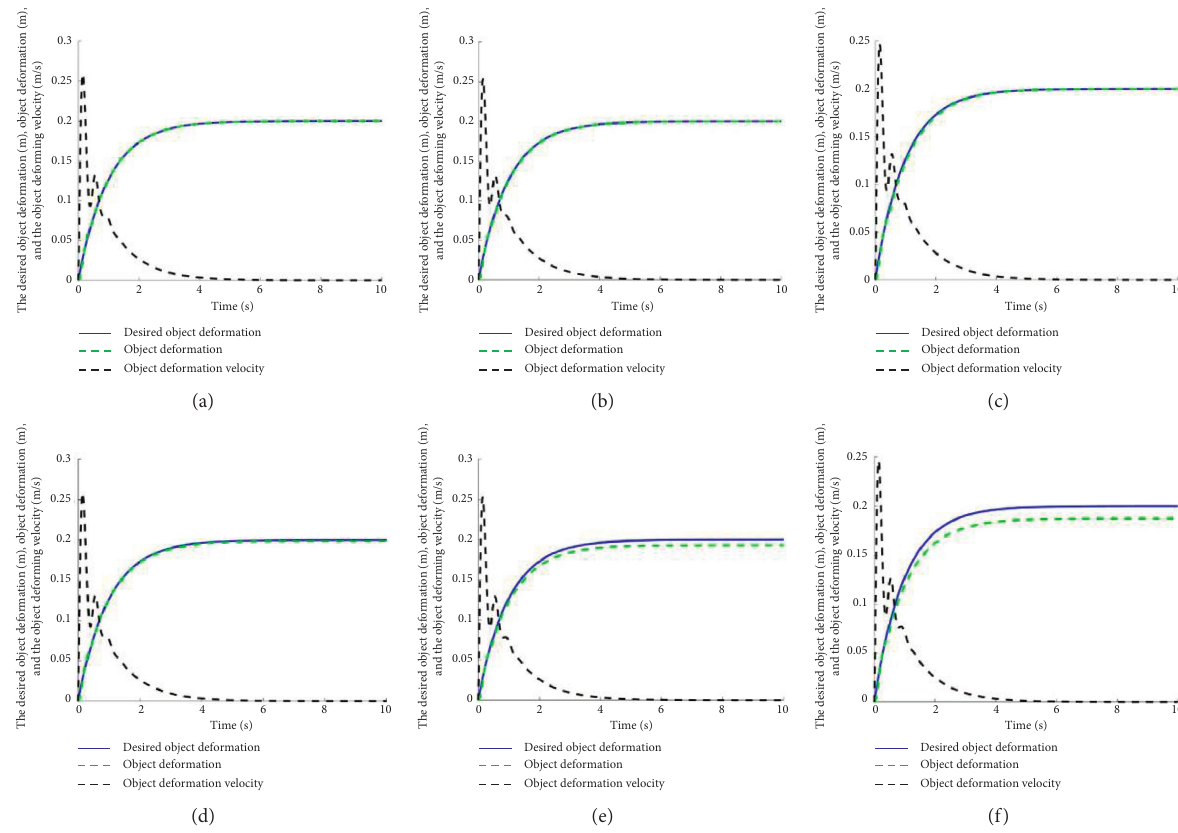
Figure 8: Comparison of deformation information of the object between the conditions with and without using force observer. (a) K with force observer, (b) K o � 5 with force observer, (c) K o � 10 with force observer, (e) K o � 1 without force observer, (f) K o � 5 without force observer, and (g) K o � 10 without force